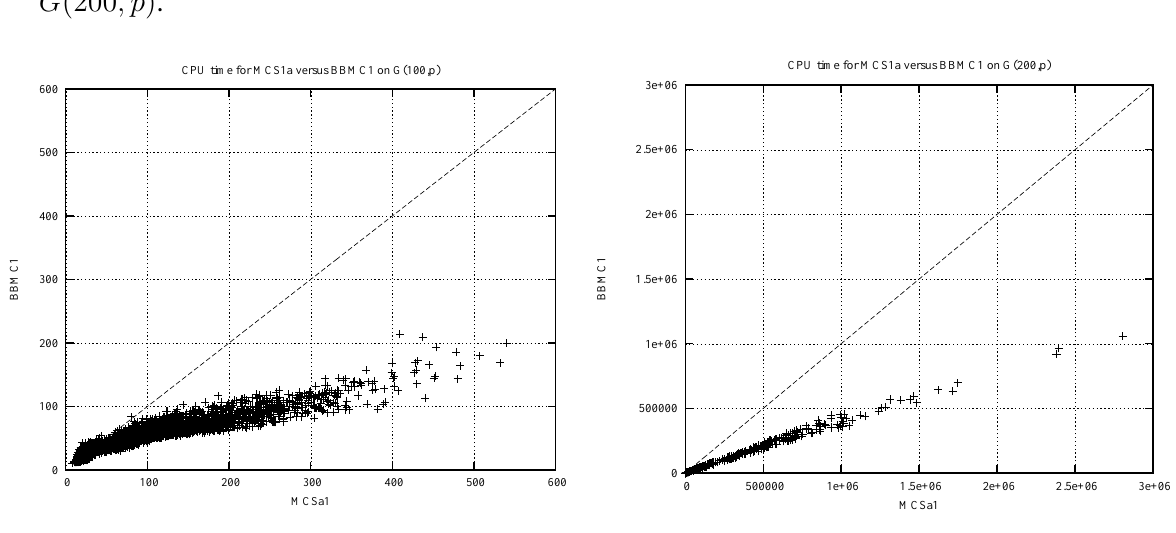
Figure 7. Run time of MCSa1 against BBMC1, on the left ( G 100 , p ) and on the right G (200 , p )